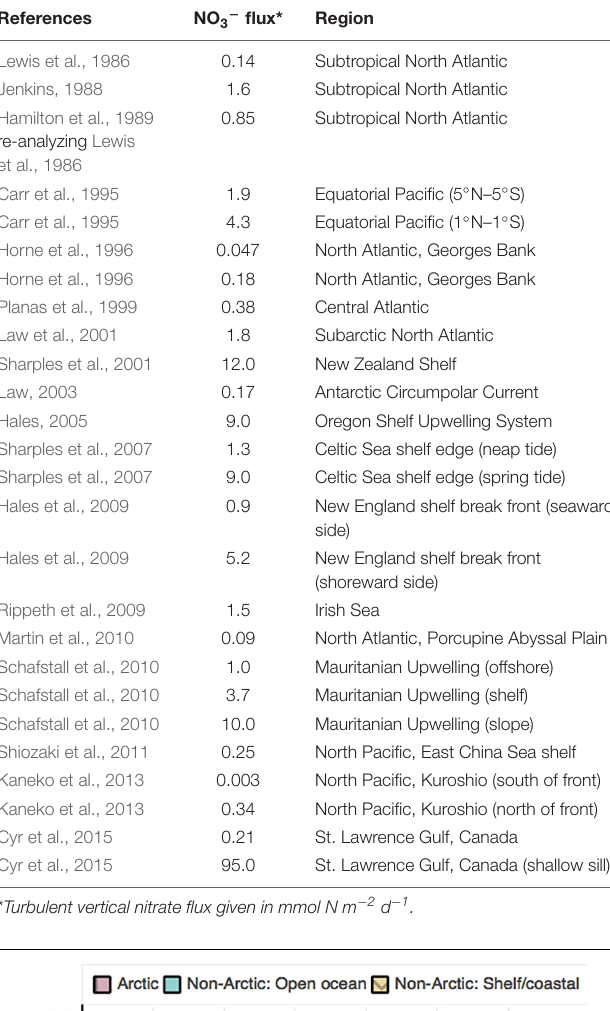
TABLE 2 | Nitrate fluxes in the global ocean, excluding the Arctic.